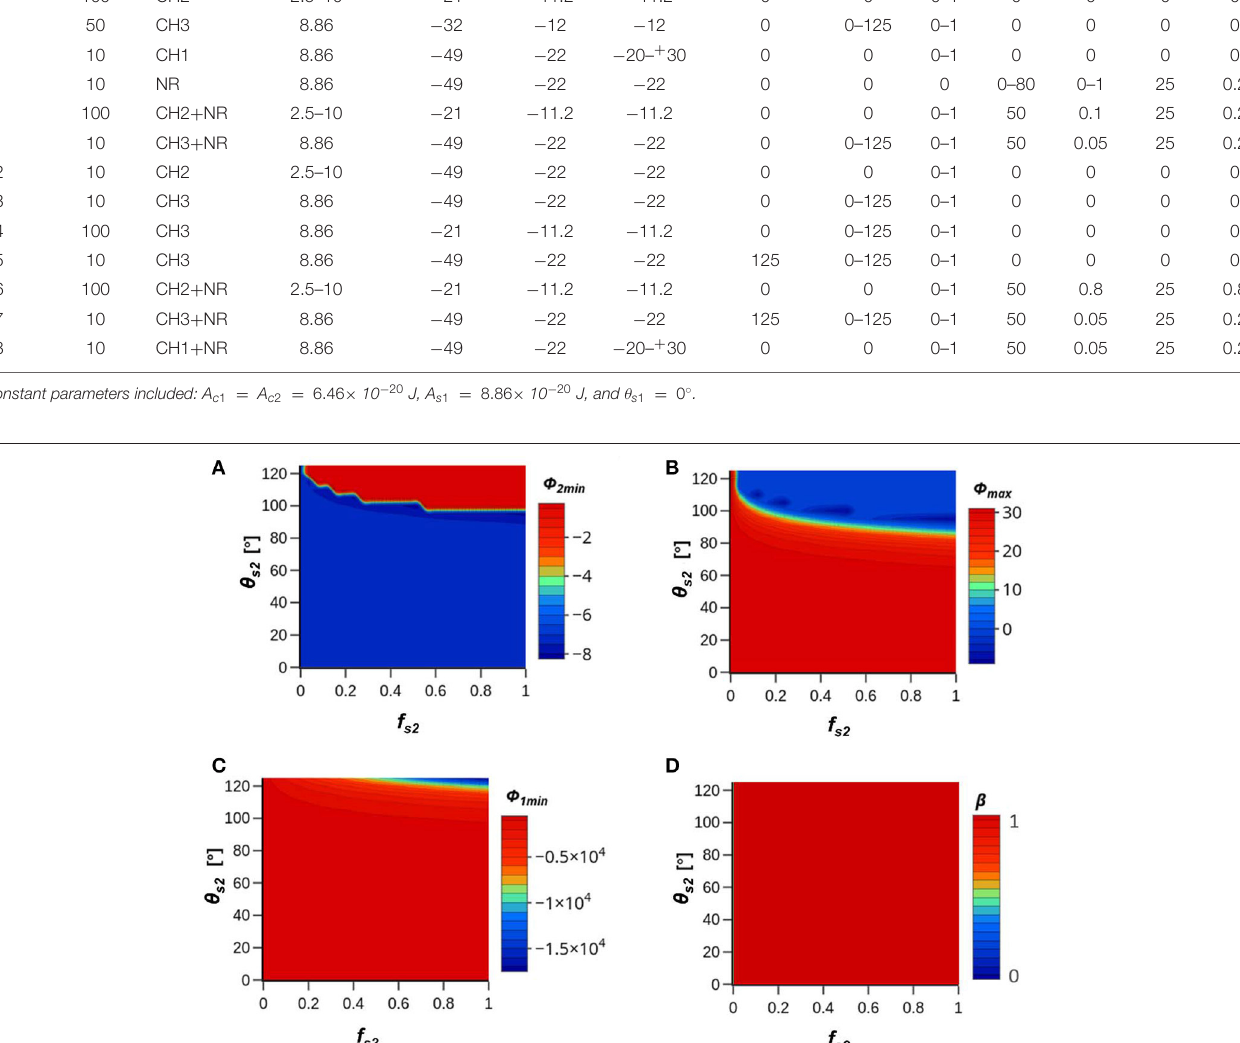
FIGURE 2 | Contour plots of (A) Φ 2min , (B) Φ max , (C) Φ 1min , and (D) β for a hydrophilic bacterium when the IS interaction on the solid phase was considered. The solid phase contact angle and fraction on site 2 were varied from θ s 2 and θ c 1 were both set to zero. Table 1 gives a summary of all